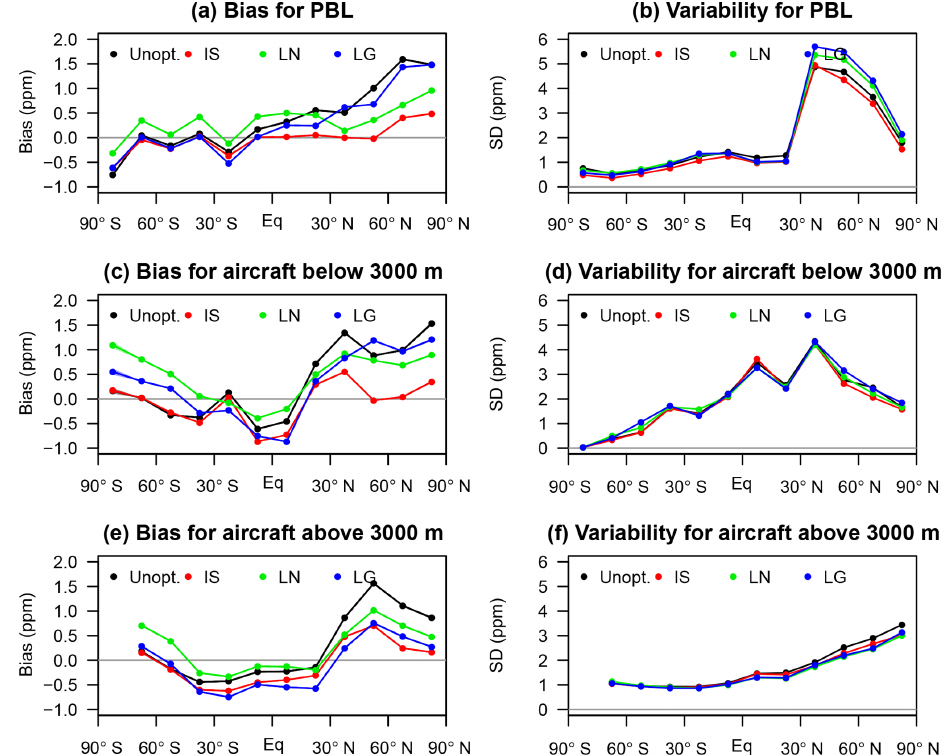
Figure 9. Comparisons between in situ measurements and unoptimized and optimized posterior concentrations using different observational constraints. Panels (a) , (c) , and (e) depict the overall bias and (b) , (d) , and (f) the standard deviation of the errors, each plotted against latitude. The rows distinguish between measurements in the PBL (a, b) , aircraft below 3000ma.s.l. (c, d) , and aircraft above 3000m (e, f) . Aircraft measurements include the NOAA light aircraft profiles (Sweeney et al., 2015), CONTRAIL flask and analyzer data, and observations from the ORCAS and ATom campaigns. The PBL measurements were assimilated in the IS experiments, which is apparent given the very low bias in (a, b) for the red curve. The IS experiments exhibit the smallest bias throughout the atmosphere in the northern extratropics and above the PBL in the southern extratropics (largely driven by ORCAS data), while the LN posterior concentrations have the lowest bias above the PBL in the tropics. LG posterior concentrations in general follow the unoptimized concentrations, with a slight negative or positive shift that depends on latitude and altitude. None of the observational constraints improves the match to the variability in the observations much over the prior